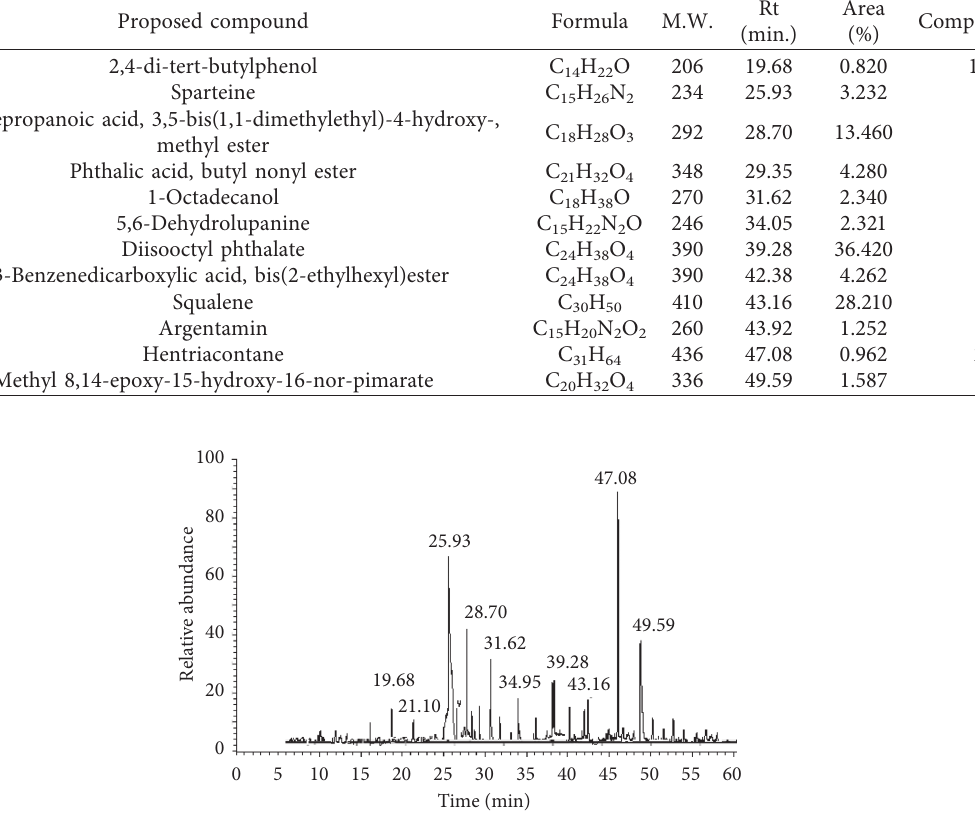
Figure 2: GC-MS-MS chromatogram of ethanol stem extract of R. raetam . Table 4: Elements and heavy metals concentration R. raetam stem (mgKg − 1